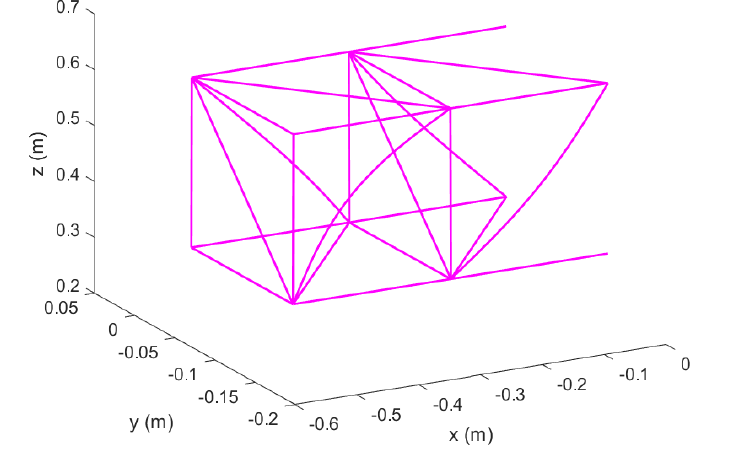
Figure 21. Mode 4 of Euler–Bernoulli Beams in Topology 1 with hinged ends; original